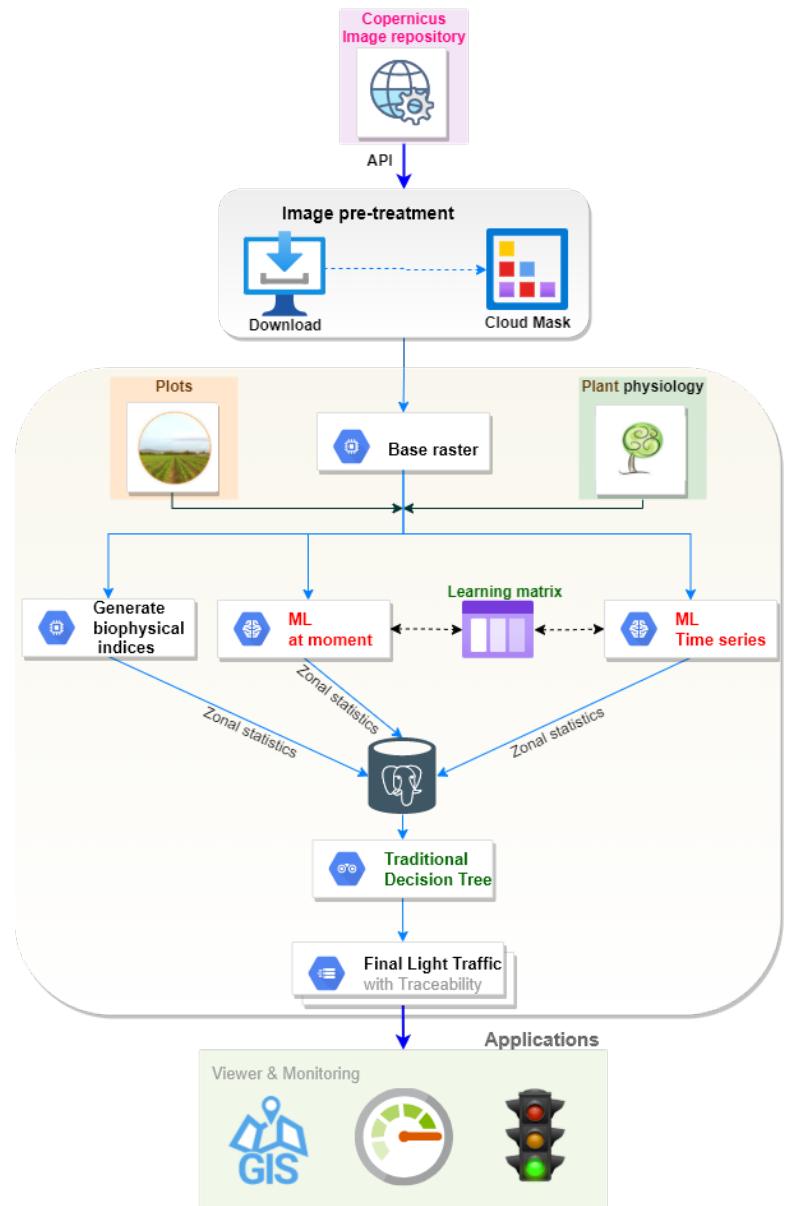
Figure 3. Scheme representing the methodology followed to identify and monitor different